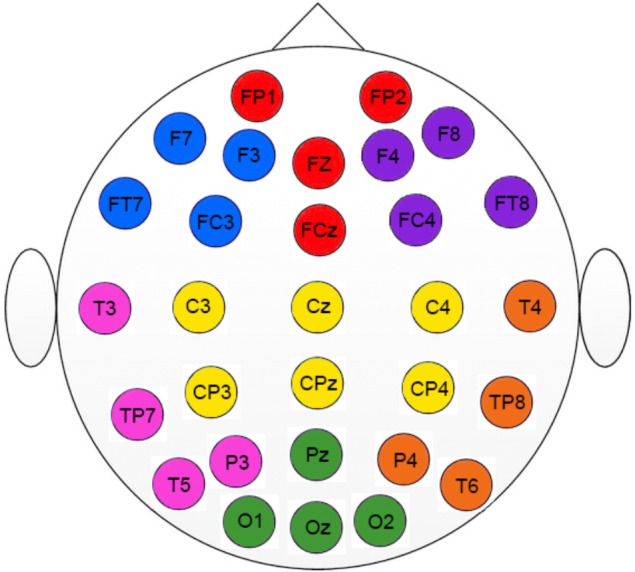
Regions of interest used in the study (ROI). Colors indicate the electrodes for each specific ROI. Left frontal (blue); Frontal (red); Right frontal (purple); Left temporal-parietal (pink); Central (yellow); Right temporal-parietal (orange); Parietal-occipital (green).